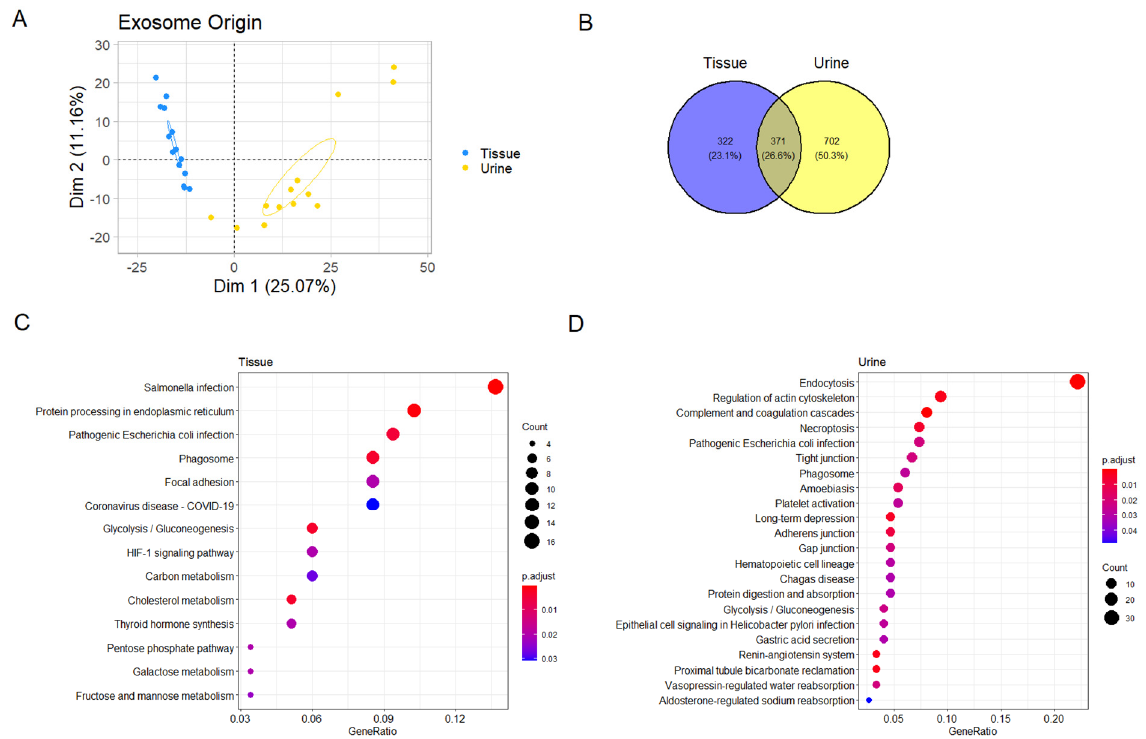
Figure 2. Comparison of tissue- and urine-derived exosomes. ( A ) Principal component analysis (PCA). Ellipses represent 95% confidence intervals. ( B ) Venn diagram of proteins uniquely detected in either urine or tissue. ( C , D ) Enrichment plots showing enriched pathways among proteins significantly higher in tissue and urine, respectively.